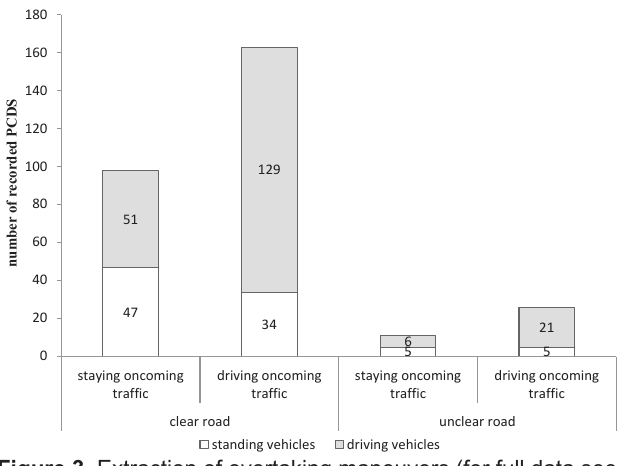
Figure 3. Extraction of overtaking maneuvers (for full data see Supplemental File C): representing oncoming traffic (bars) and traffic in driving direction (legend) depending on the clarity of the road (horizontal axis). PCDS , potentially critical driving